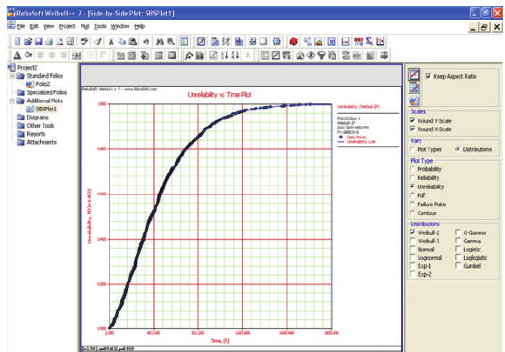
Figure 10: Unreliability versus power.